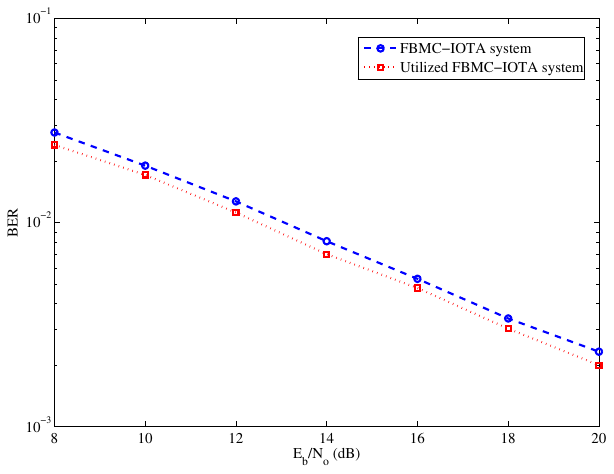
Figure 2. Effect of